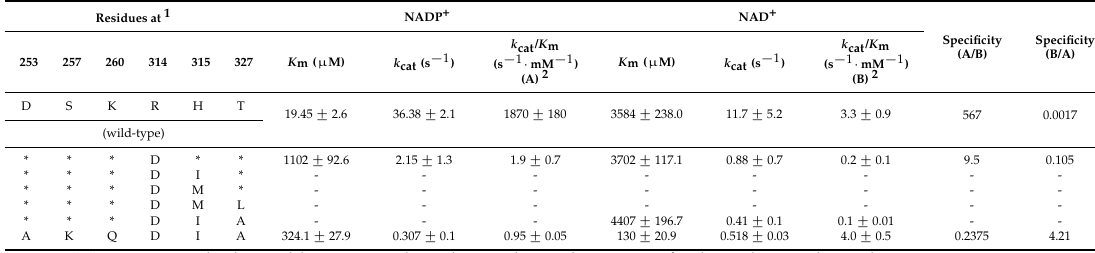
Table 2. The kinetic parameters of wild-type Bl IDH and mutants.